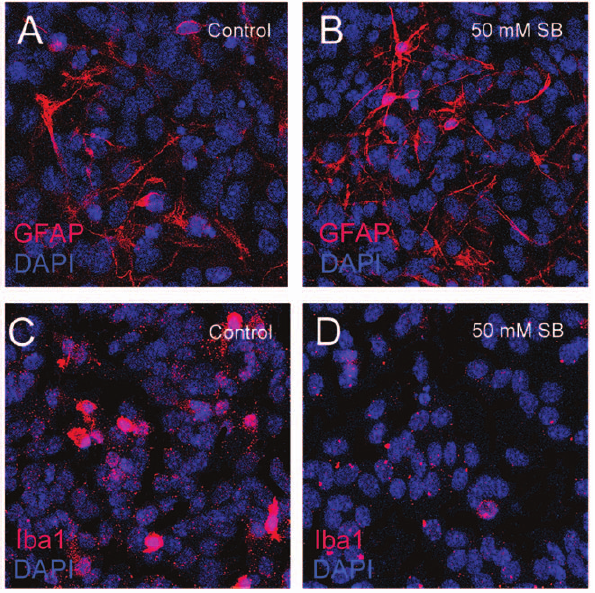
Figure 7. Identification of GFAP-expressing astrocytes and Iba1-expressing microglia after 24 hours of HDACi treatment. Similar numbers of GFAP positive astrocytes (red) in a control midbrain culture (A) compared to cultures treated with 50 mM SB for 24 hours (B). The same treatment reduces the number of Iba1 positive cells in midbrain cultures compared to controls (C, D). Blue=DAPI positive nuclei.